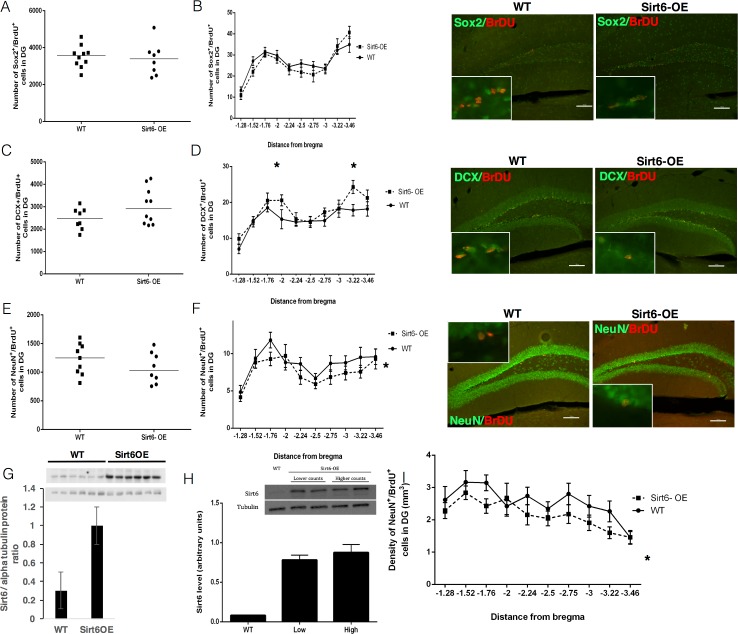
Sirt6-OE alters hippocampal neurogenesis.(A) Sox2+/BrdU+ cells were counted for each animal's SGZ in random bregma positions using the optical fractionator probe (Stereoinvestigator software, MBF bioscience), and total SGZ population estimation was extrapolated. Results were averaged across genotype group. No significant difference was found in total Sox2+/BrdU+ cells (t-test, p = 0.71). (B) Left panel: Distribution of Sox2+/BrdU+ neural progenitor cells in the SGZ of WT and Sirt6-OE mice. Results were averaged across genotype groups for each hippocampal slice according to distance from bregma position. No significant effect was found for genotype (2-way ANOVA, P = 0.14). Right panel: representative Sox2+/BrdU+ cell in the SGZ of WT and SIRT6-OE mice. (C) DCX+/BrdU+ cells were counted in the granular layer at random distances from bregma using an optical fractionator probe, and total SGZ population estimation was extrapolated for each animal. Results were averaged each across genotype. A higher, but not significant, number of total DCX+/BrdU+ cells were observed in Sirt6-OE mice compared to WT littermates (3022 ± 254.7 and 2469 ± 170.1 for WT and Sirt6-OE mice respectively, P = 0.1069, t-test). (D) Left panel: Distribution of DCX+/BrdU+ neural progenitor cells in the SGZ of WT and Sirt6-OE mice. Results were averaged across genotype group for each hippocampal slice according to distance from bregma. A significant genotype effect was found (2-way ANOVA, P = 0.005). Right panel: representative DCX+/BrdU+ cell in the SGZ of WT and SIRT6-OE mice. (E) NeuN+/BrdU+ cells were counted in the granular layer in random distances from bregma using an optical fractionator probe, and total SGZ population estimation was extrapolated for each animal. Results were averaged across genotype group. A lower, but not significant, number of total NeuN+/BrdU+ cells were observed in Sirt6-OE mice compared to WT littermates (1228 ± 90.68 and 1076 ± 95.36 for WT and Sirt6-OE mice respectively, P = 0.26, t-test). (F) Left panel: Number of total NeuN+/BrdU+ mature neurons in the SGZ of WT and Sirt6-OE mice. NeuN+/BrdU+ cells were counted in the granular layer in random distances from bregma in each animal using an optical fractionator probe. Results were averaged across genotype group for each hippocampal slice according to distance from bregma. A significant genotype effect was found (two-way ANOVA, F(1,19) = 3.989, p = 0.018 for genotype effect). Right panel: representative NeuN+/BrdU+ cell in the SGZ of WT and SIRT6-OE mice. (G) Protein levels of WT and Sirt6-OE mice. Western blot analysis of WT and Sirt6-OE mice, blotted for SIRT6 and the house-keeping protein, α-tubulin. A robust increase in SIRT6 levels is clearly seen in Sirt6-OE mice. () Hippocampal SIRT6 protein levels from mice with high and low early neuron population numbers in the Sirt6-OE group. Upper panel. Western blot analysis of SIRT6 levels in Sirt6-OE mice with the highest and lowest new early neuron population counts, compared to a WT mouse with an average population count. Lower panel: Densitometric quantification of the corresponding bands was performed using ImageJ analysis software and each group was averaged. (I) NeuN+/BrdU+ cells were counted in the granular layer in random distances from bregma in each animal using an optical fractionator probe. Results were averaged across genotype for each bregma position and divided by the DG volume. A significant genotype effect was found (two-way ANOVA, F(1,19) = 10.09, * p = 0.0017 for genotype main effect). Immunofluorescence images were taken at 10x magnification, scale bar = 20μm. Insets represent 63x magnification.